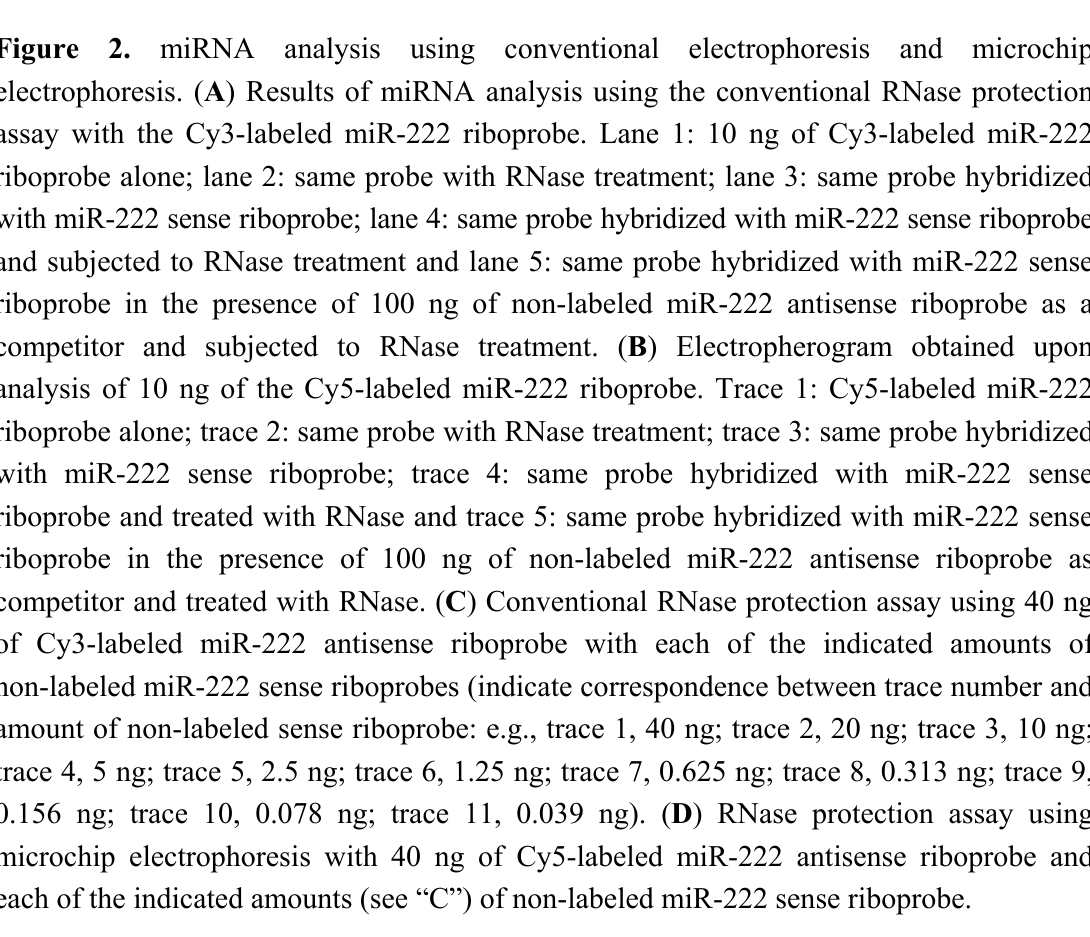
Figure 2. miRNA analysis using conventional electrophoresis and